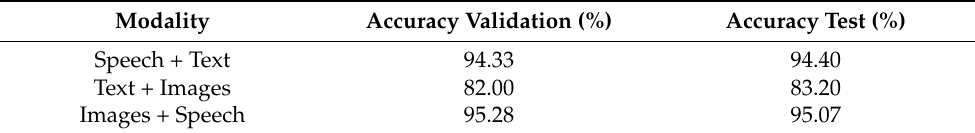
Table 6. Results of multimodal prediction of trust using combinations of two modalities.